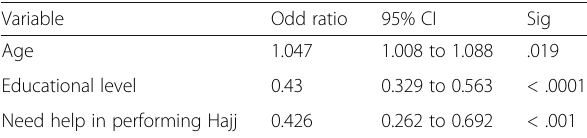
Table 3 Significant odd ratios and 95% CI from univariate logistic regression analysis predicting positive MINI-Cog